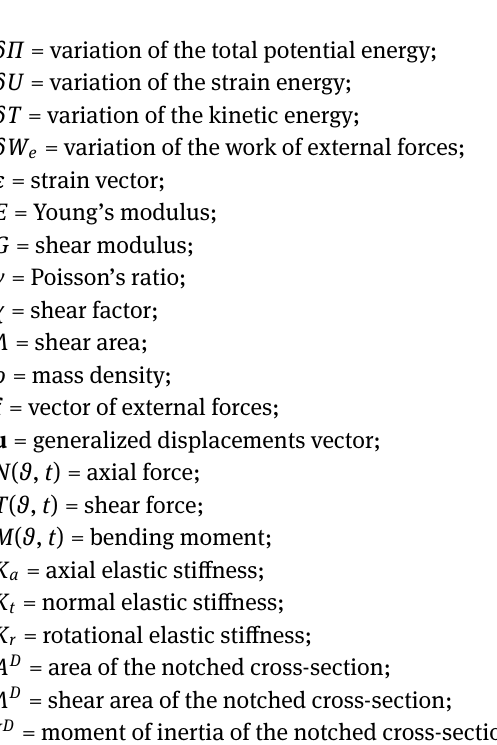
Figure 9: First modal shapes for Hinged-Clamped parabolic arches in different damage configurations.